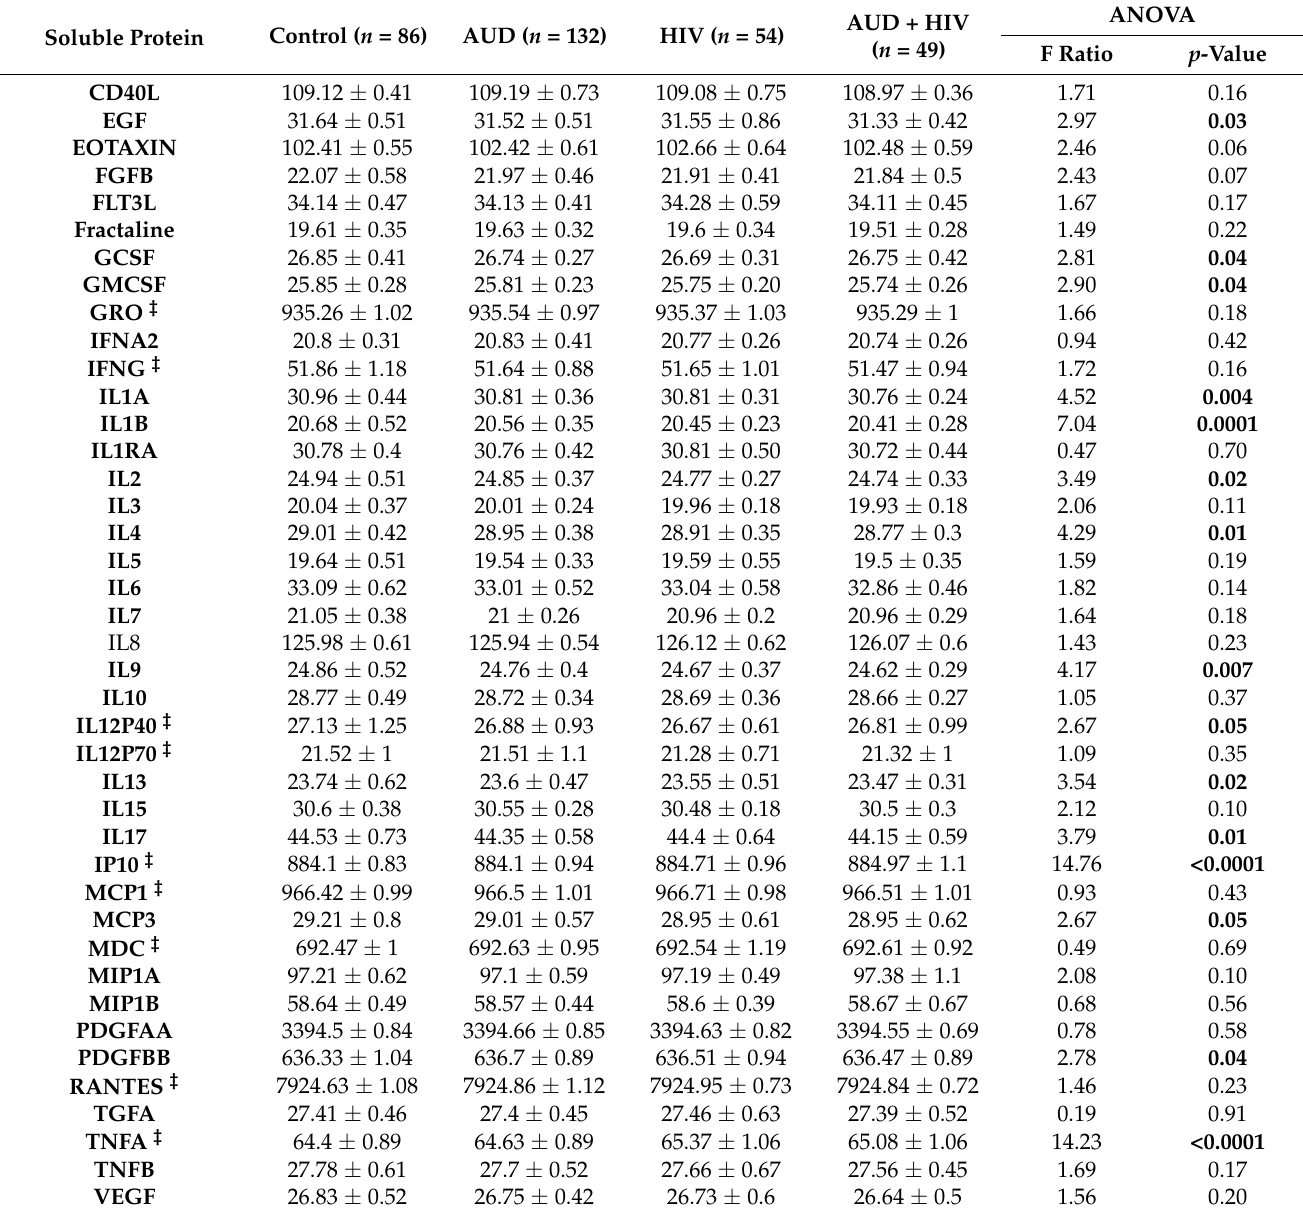
Table 2. Soluble protein levels * in the 4 study groups: mean ± SD and ANOVA